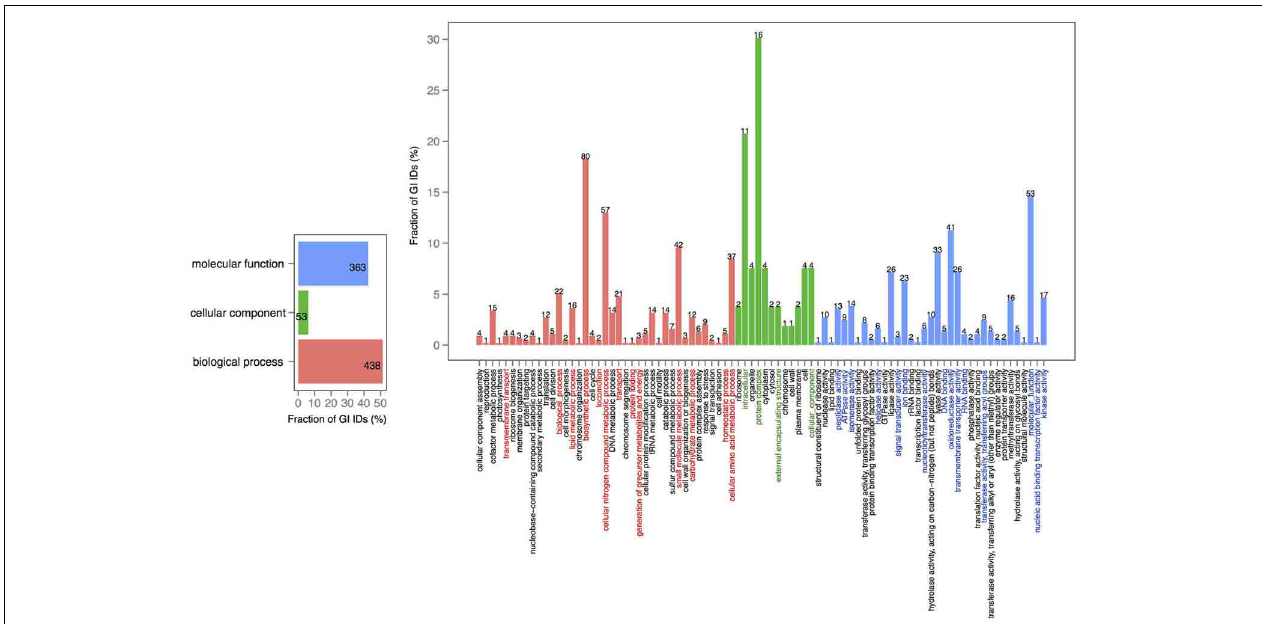
FIGURE 5 | GO term analysis in protein coding genes shared within chromosome2andmissinginthecoreofchromosome1. Thedistributionis shared both as percentage on the axis and the absolute number above the bar.